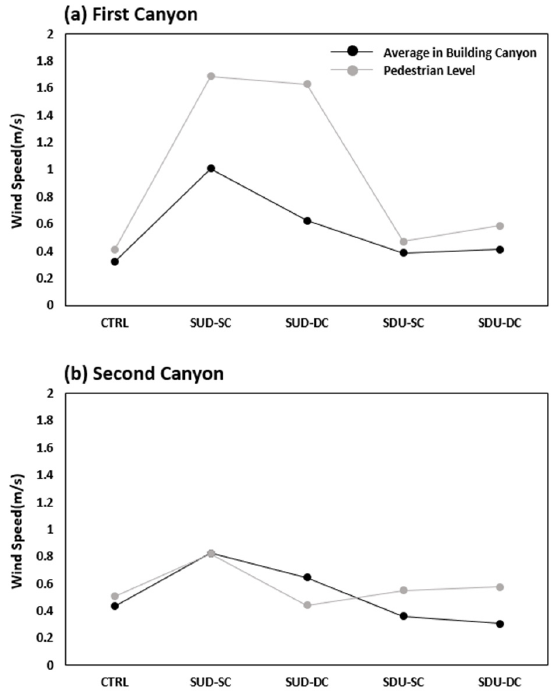
Figure 13. Averages of the windspeed of the in-canyon regions of the ( a ) first canyons and ( b ) second canyons. ond